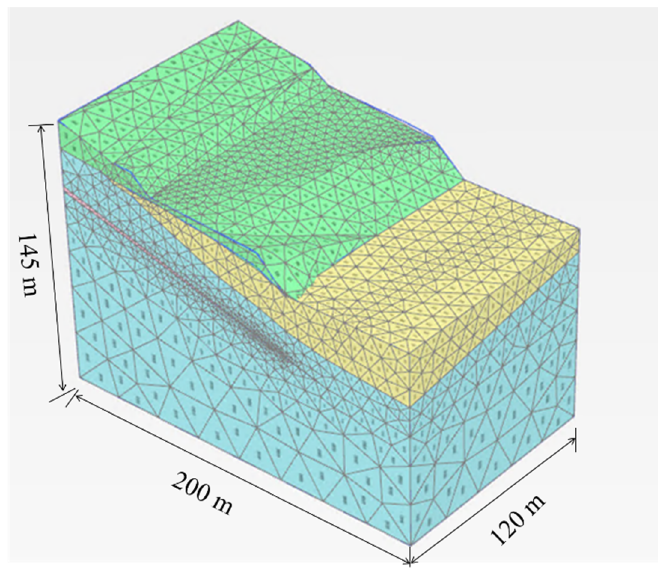
Figure 5. Calculation model diagram.